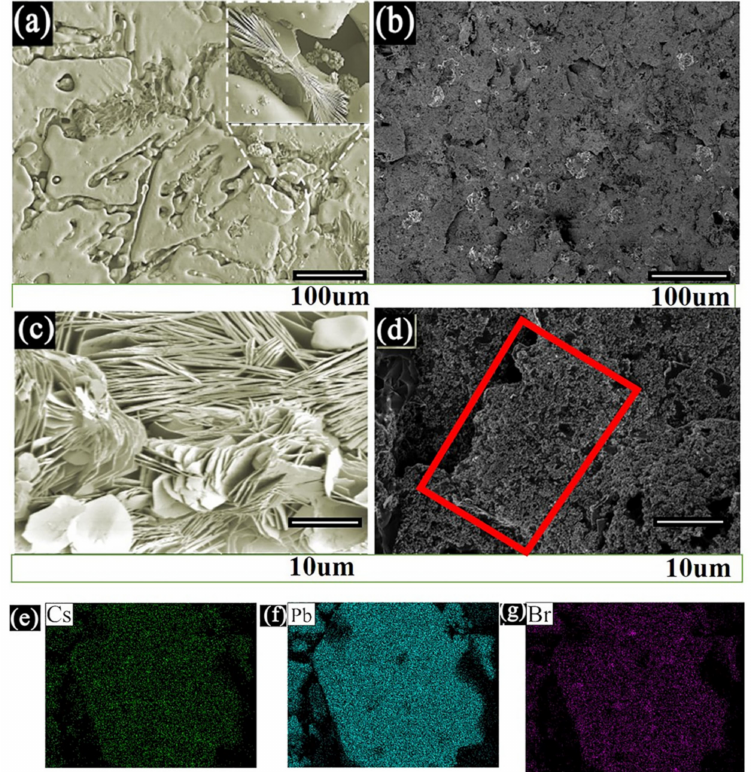
Figure 1. SEM of CQDs ( a , c ), SEM of 35% CQDs/G ( b , d ) and the mapping of CQDs/G composite material ( e – g